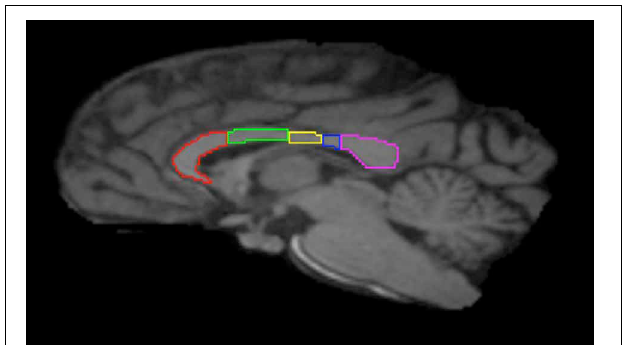
FIGURE 3 | Midsagittal section illustrating the subdivisions of the corpus callosum as determined by tractography. Region I (red) = prefrontal cortex; Region II (green) = premotor and supplementary motor cortices; Region III (yellow) = motor cortex; Region IV (blue) = sensory cortex; Region V (violet) = parietal, temporal and occipital cortices.